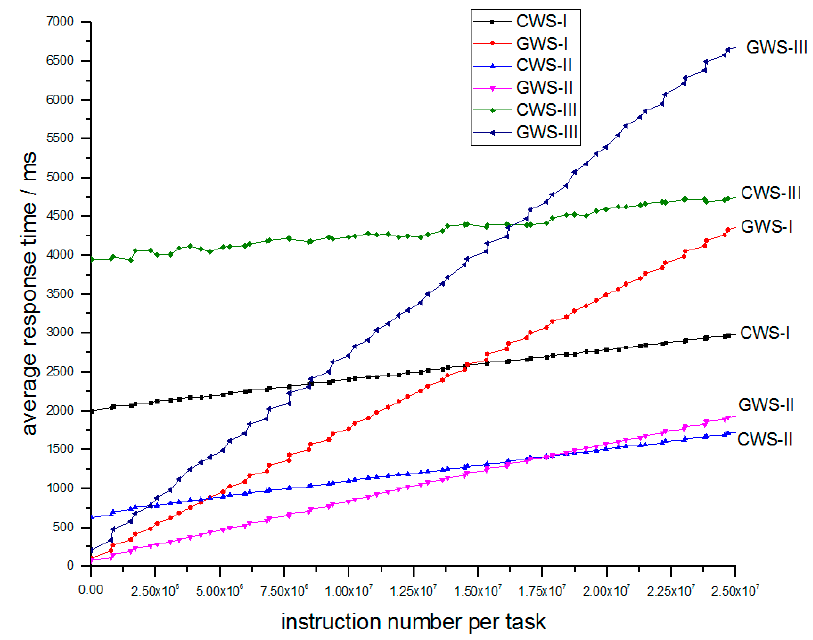
Figure 11. Relation of average response time and number of instructions per task between different arrival rates.